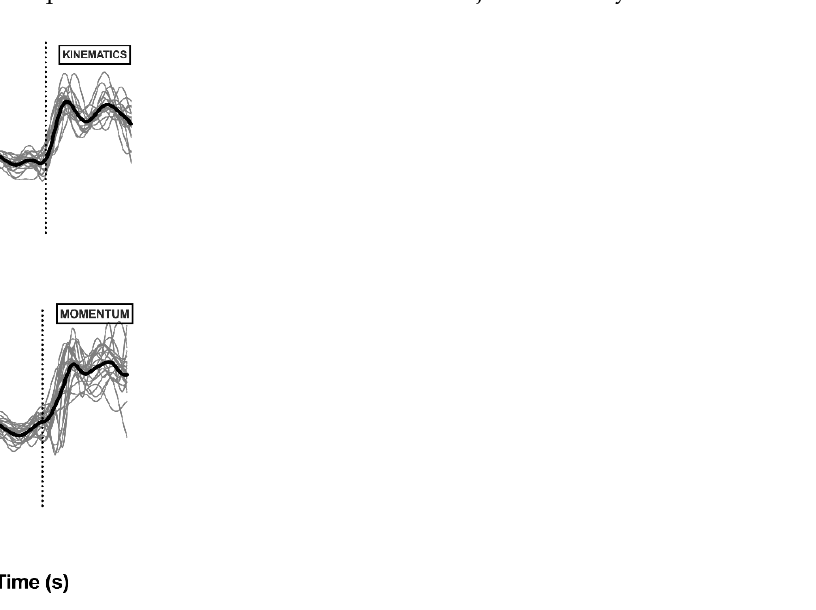
Figure 4. COM accelerations of each subject and resultant from first session. Data from kinematics and Momentum app are represented. Thick line represents average resulting from 20 subjects. Dashed line represents heel-off moment. (ML: